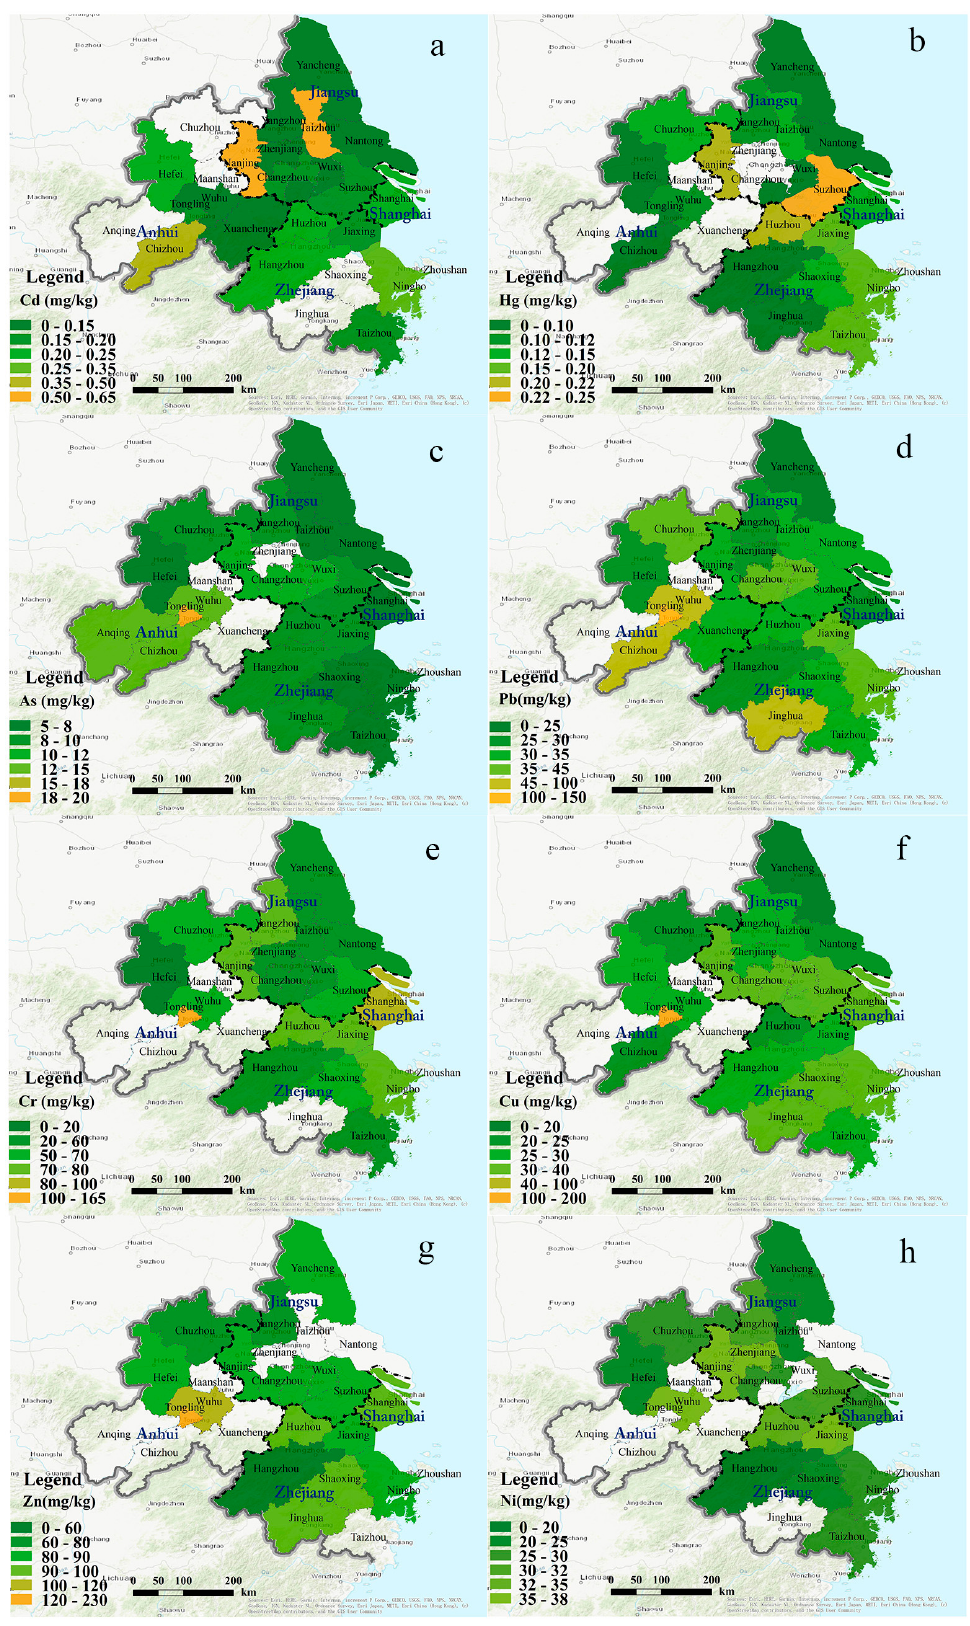
Figure 4. Spatial distribution of ( a ) Cd; ( b ) Hg; ( c ) As; ( d ) Pb; ( e ) Cr; ( f ) Cu; ( g ) Zn; and ( h ) Ni concentrations in the cities of the Yangtze River Delta (YRD).